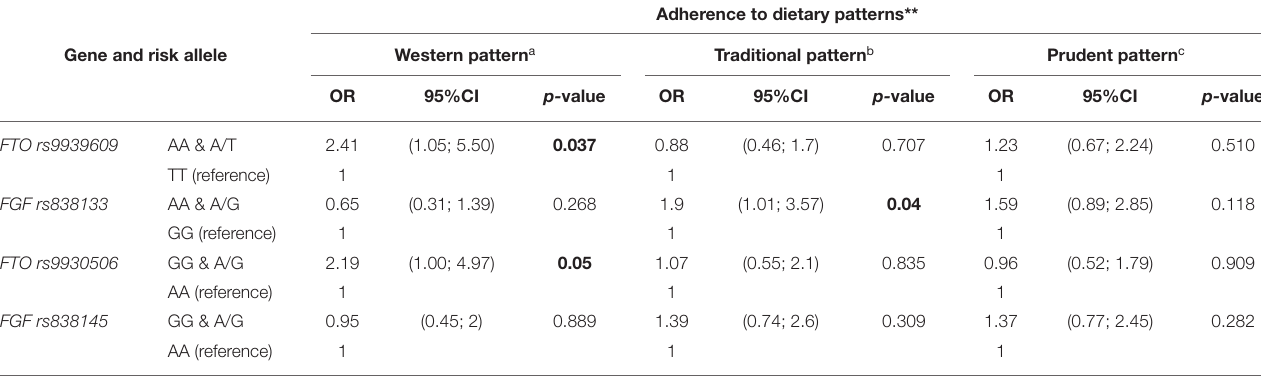
Adherence to dietary patterns**